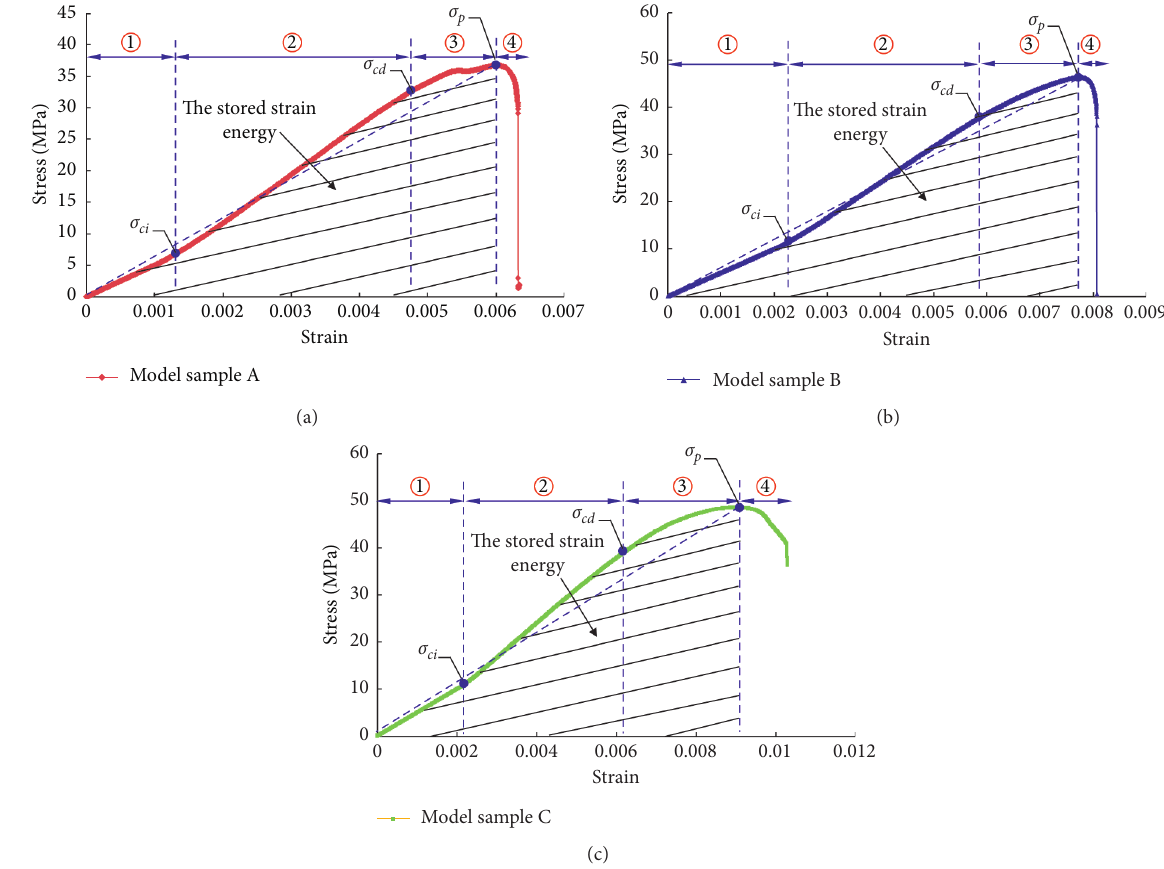
Figure 4: Curves of stress versus strain of three types of model samples: (a) model sample A; (b) model sample B; (c) model sample C ( ① , ② , ③ , and ④ indicate the elastic deformation stage, stable crack propagation stage, unstable crack propagation stage, and postpeak stage) (after [23]). Table 2: The stress and strain threshold between different stages of stress versus strain curves for three types of model samples. Type of model samples Model sample A σ ci , σ c d , σ p ,and ε p arethe crackinitiationstress,thatis, theelasticlimiting stressinthis paper, thecrackdamage stress,thepeak compressivestrength,and the peak strain,